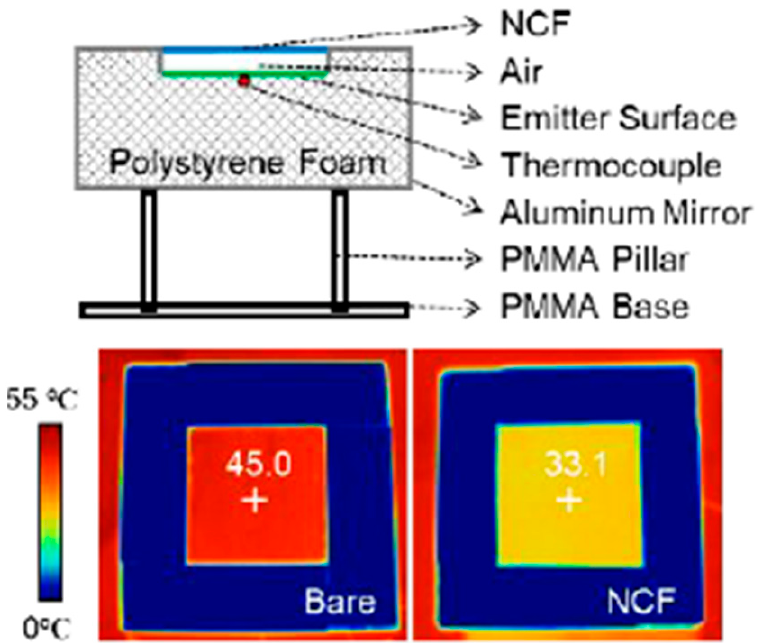
Figure 39. The NCF-based radiative cooler schematic and thermal images of the bare and NCF-based radiative cooling devices [177].